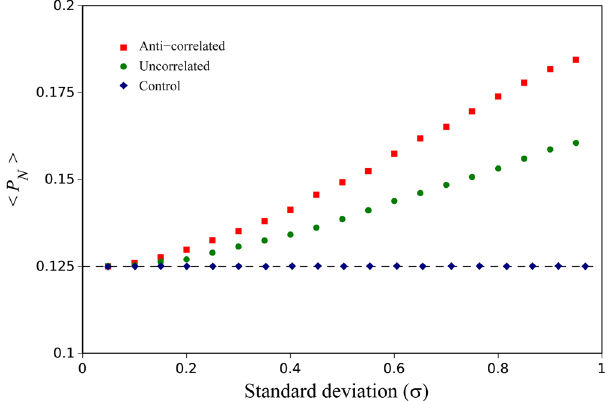
Figure 1. The average mutant fixation probability (starting with one mutant cell) as a function of the standard deviation of the bimodal fitness distribution for different degrees of correlation between mutant and non- mutant fitness values ( N = 8), obtained from the exact analytical calculations for the death-birth Moran process (see the Method Section).